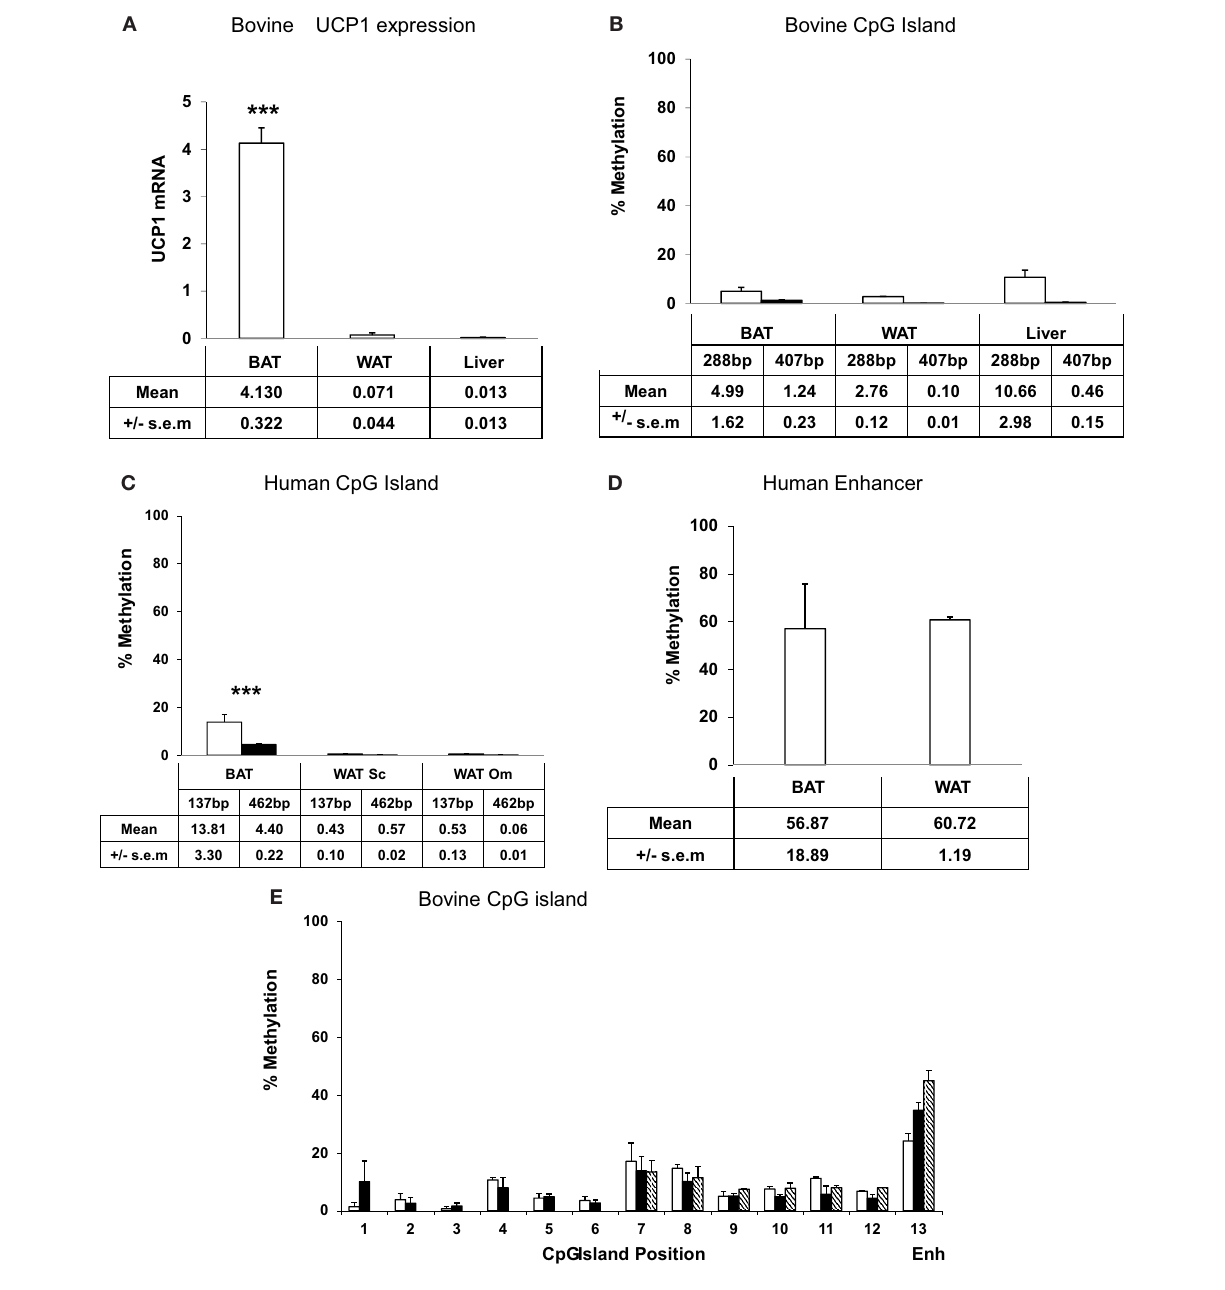
FIGURE 1 | Expression and UCP1 promoter percentage CpG methylation. (A) bovine UCP1 mRNA expression by qRTPCR. Methylation sensitive restriction digest determination of (B) bovine, (C) human CpG islands, (D) human enhancer, and (E) bisulfite mapping determination of the percentage methylation of 12 CpGs within the bovine CpG island, in adipose tissues and liver. UCP1 mRNA (A) is expressed relative to ribosomal 18S mRNA.The data are presented as a percentage methylation compared to each respective mock methylated sample for the (B) bovine 288bp ( (cid:3) ) and the 407bp ( (cid:4) ) products and (C) human 173bp ( (cid:3) ) and the 426bp ( (cid:4) ) products and (D) human enhancer (see Materials and Methods).The amount of UCP1